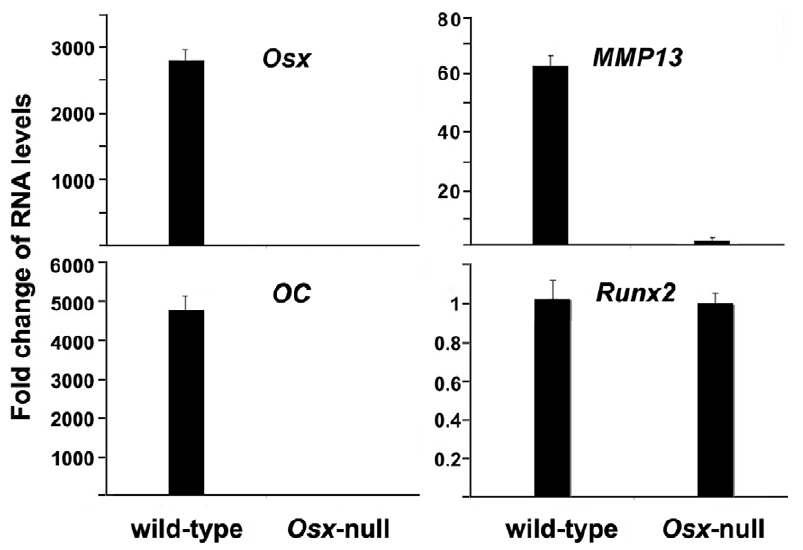
Figure 1. Osx ablation reduces MMP13 gene expression in vivo. Calvaria RNAs were isolated from E18.5 Osx wild-type and Osx -null embryos. RNA expression levels for Osx, osteocalcin (OC), Runx2 and MMP13 were analyzed by real-time RT-PCR. The level of each RNA from Osx -null calvaria was normalized to a value of 1. Values are presented as the mean 6 S.D.